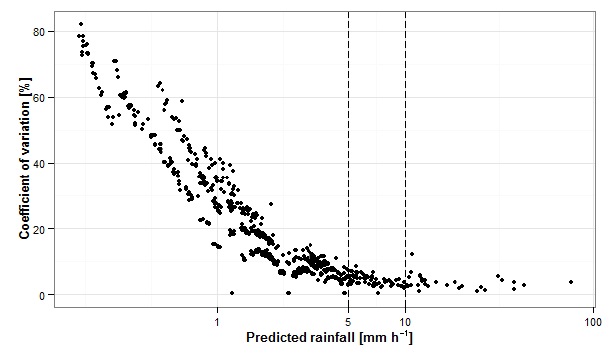
Figure 9. AARI prediction error CV (%) values against predicted AARI for averaging interval of